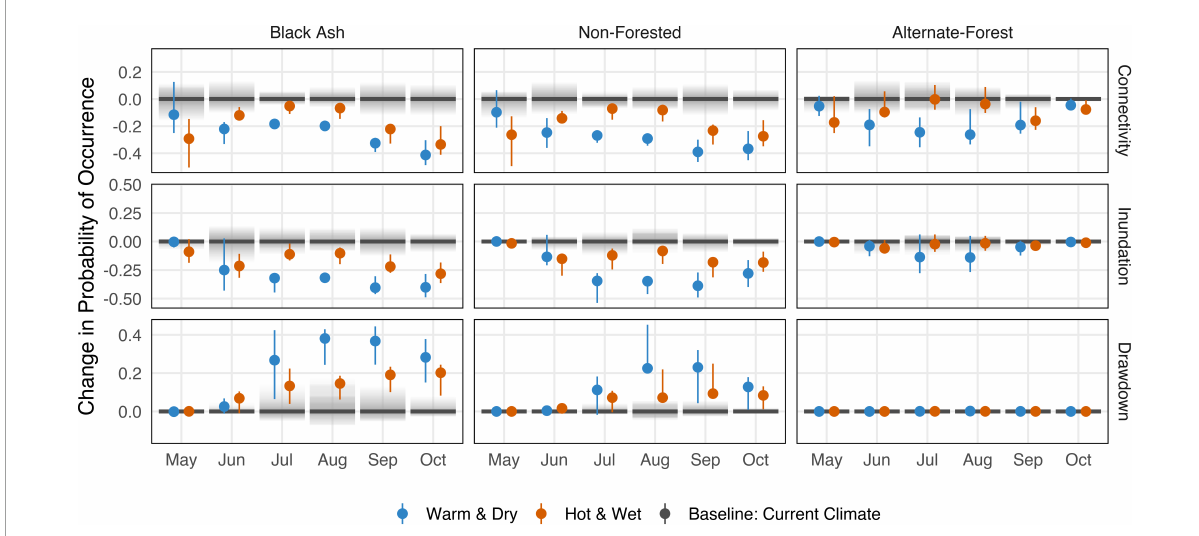
FIGURE6 Change in probability of occurrence for critical ecohydrological wetland water levels (connectivity, inundation, drawdown) under combinations of vegetative cover (black ash, alternate-forested, non-forested) and climate conditions (warm & dry, hot & wet) relative to the respective vegetative cover under current climate baseline. Each column compares simulated wetland response within a fixed vegetation condition across multiple climate scenarios. Values are reported as the median (point/bar) and the bounds of a 67% highest density continuous interval (HDCI, an interval, potentially asymmetric, that contains 67% of simulated values). For some combinations of vegetation conditions and climate scenarios the HDCI may be indistinguishable from the point estimate. Blue and orange colors represent warm & dry and hot & wet future climate scenarios, respectively. Gray shaded area represents HDCI of modeled baseline.